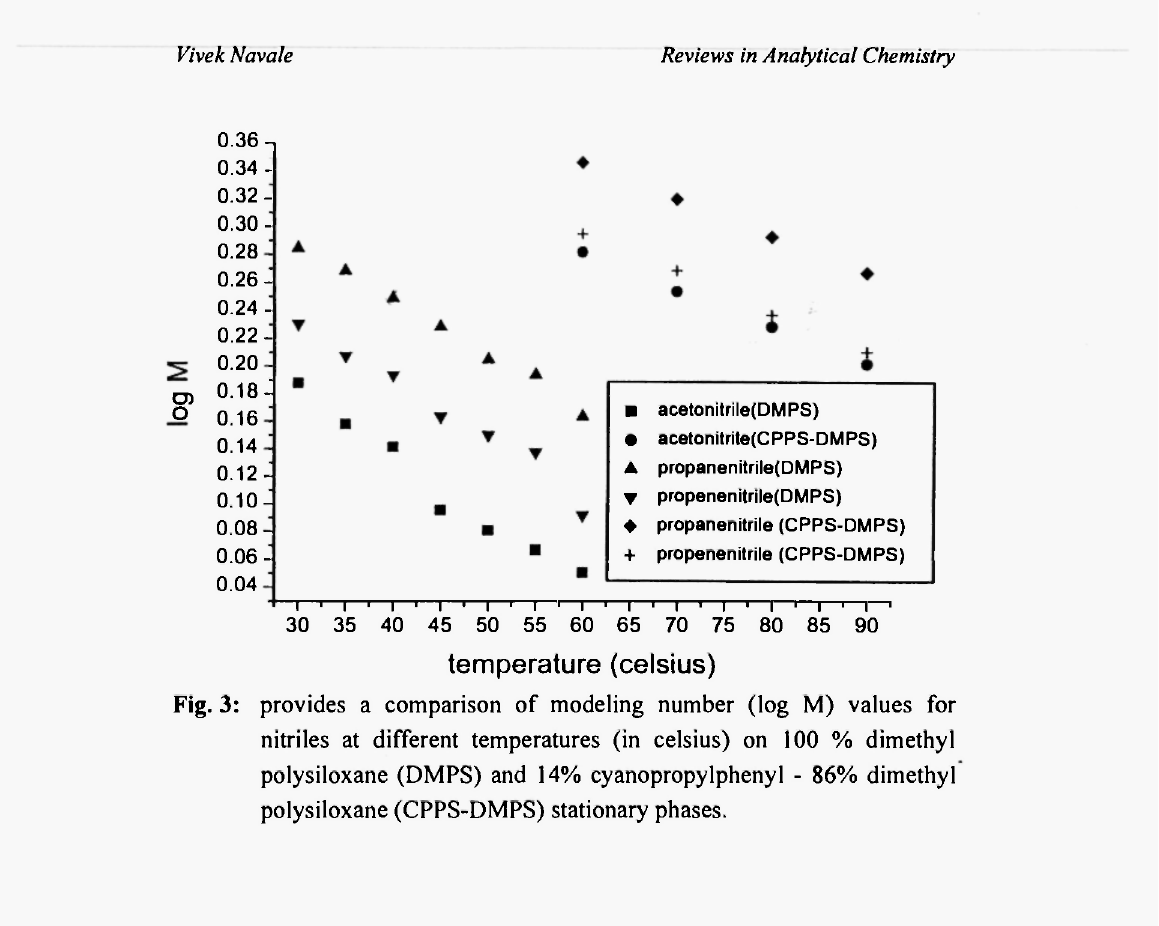
—I 1—I 1 1 1 1 !—I 1 1 1—I—I—I 1—I 1—I—1—I—I—, 1—I—I 30 35 40 45 50 55 60 65 70 75 80 85 90 temperature Fig. 3: